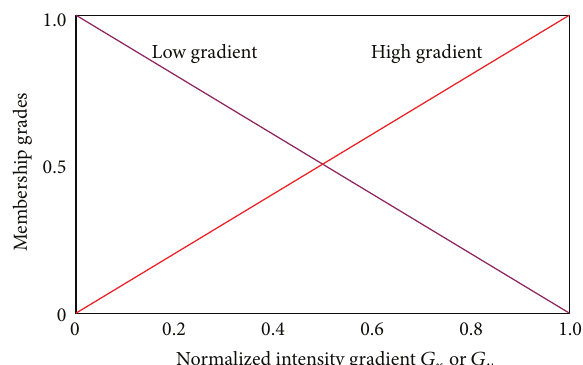
Figure 1: Membership function plots for fuzzy sets corresponding to low and high intensity gradient